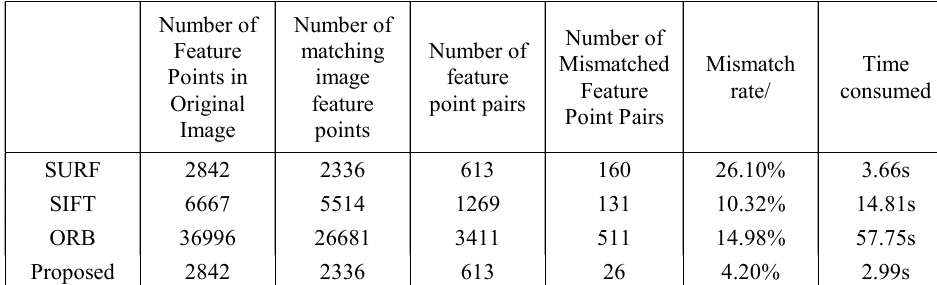
Table 1. Table of Experimental Results of Four Matching